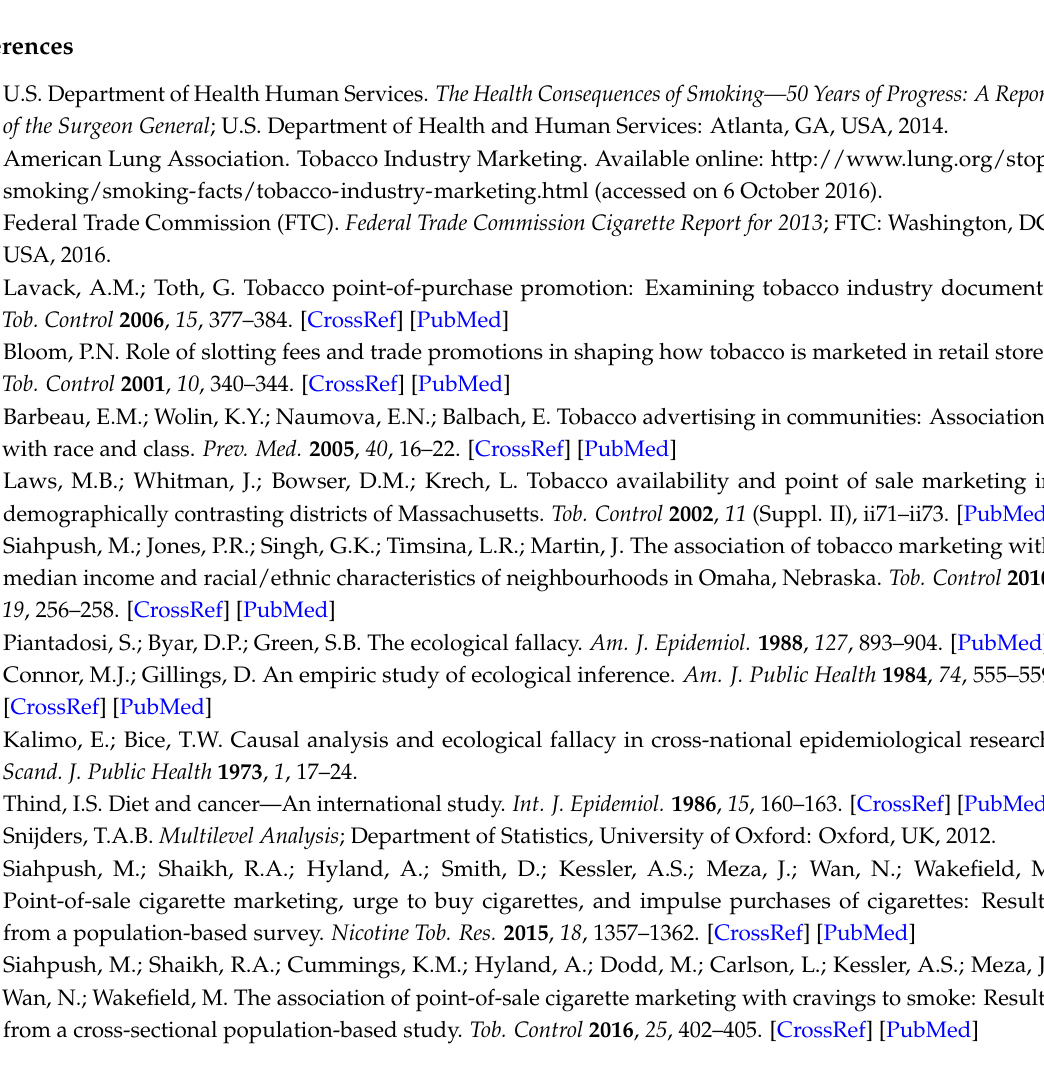
Table S1: Odds ratios (OR) and 95% confidence intervals (CI) from ordered logistic regression of POS cigarette marketing on area-level sociodemographic